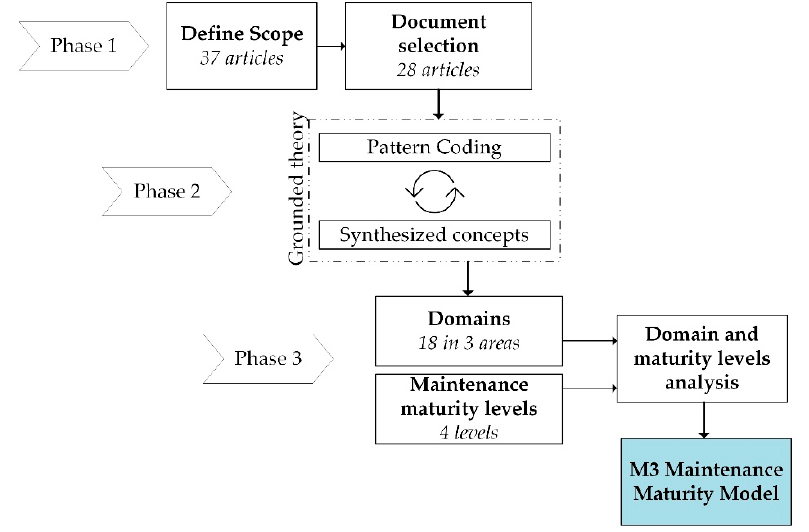
Figure 2. Methodology diagram.